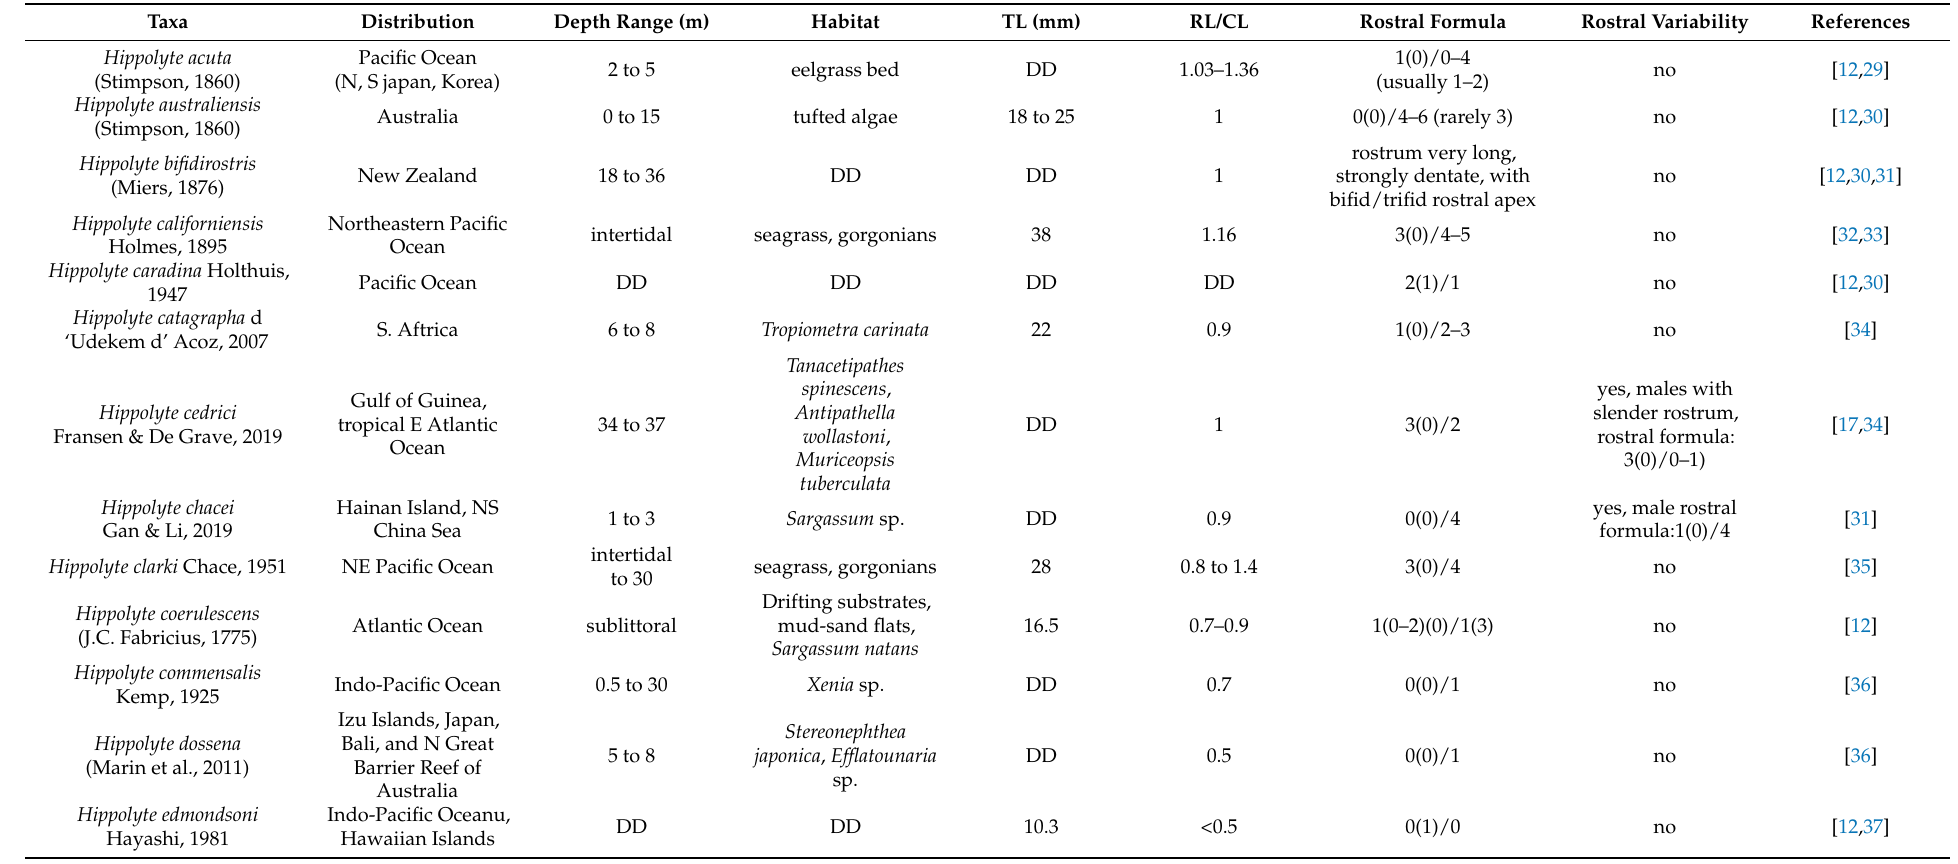
Table 1. Zoogeographical distribution, habitat characteristics, rostral formula and body lengths for Hippolyte species. Rostral formula: a(b)/c(d), a: dorsal teeth, b: postrostral teeth, c: ventral teeth, d: usual number of ventral teeth. TL: total length, CL: carapace length, RL: rostral length, DD: data